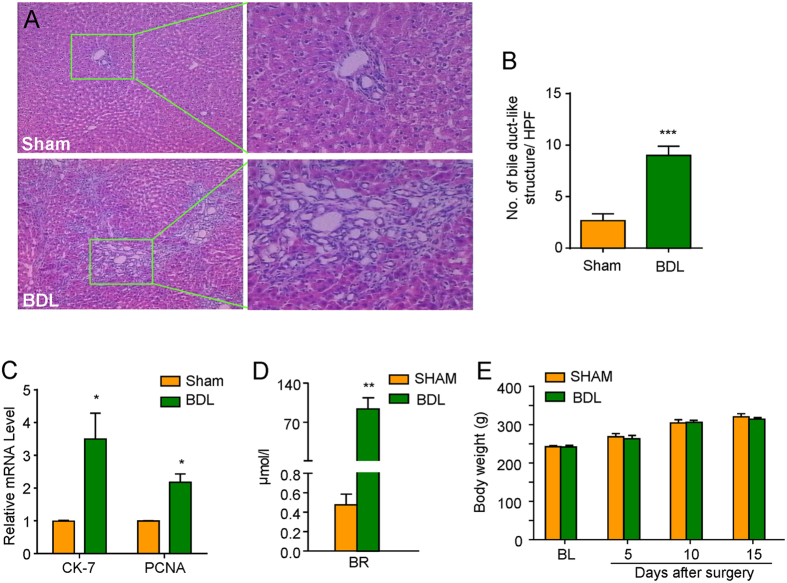
Cholestasis was induced by common bile duct ligation (BDL) in rats.(A) Representative H&E staining photomicrographs of liver section in sham and BDL rats. Compared to SHAM control rats, the bile duct had obvious atypical hyperplasia in the BDL rats at the 4th week after surgery (×200). The right pictures are higher magnification of boxed area in left pictures. (B) Quantification of bile duct-like structure in liver sections from the sham and BDL rats. (C) qPCR analysis showed that the mRNA expression of CK-7 and proliferating cell nuclear antigen (PCNA) were significantly increased in BDL rats compared to the sham rats. (D) The level of serum total bilirubin (BR) was significantly increased in BDL rats compared to sham rats at the 4th week after BDL surgery. n = 4–6 per group. (E) There was no significant difference for the body weight between sham and BDL rats (n = 12 per group) (**P < 0.01 versus sham group and analyzed by Student’s t-test or two-way ANOVA followed by Bonferroni’s test).